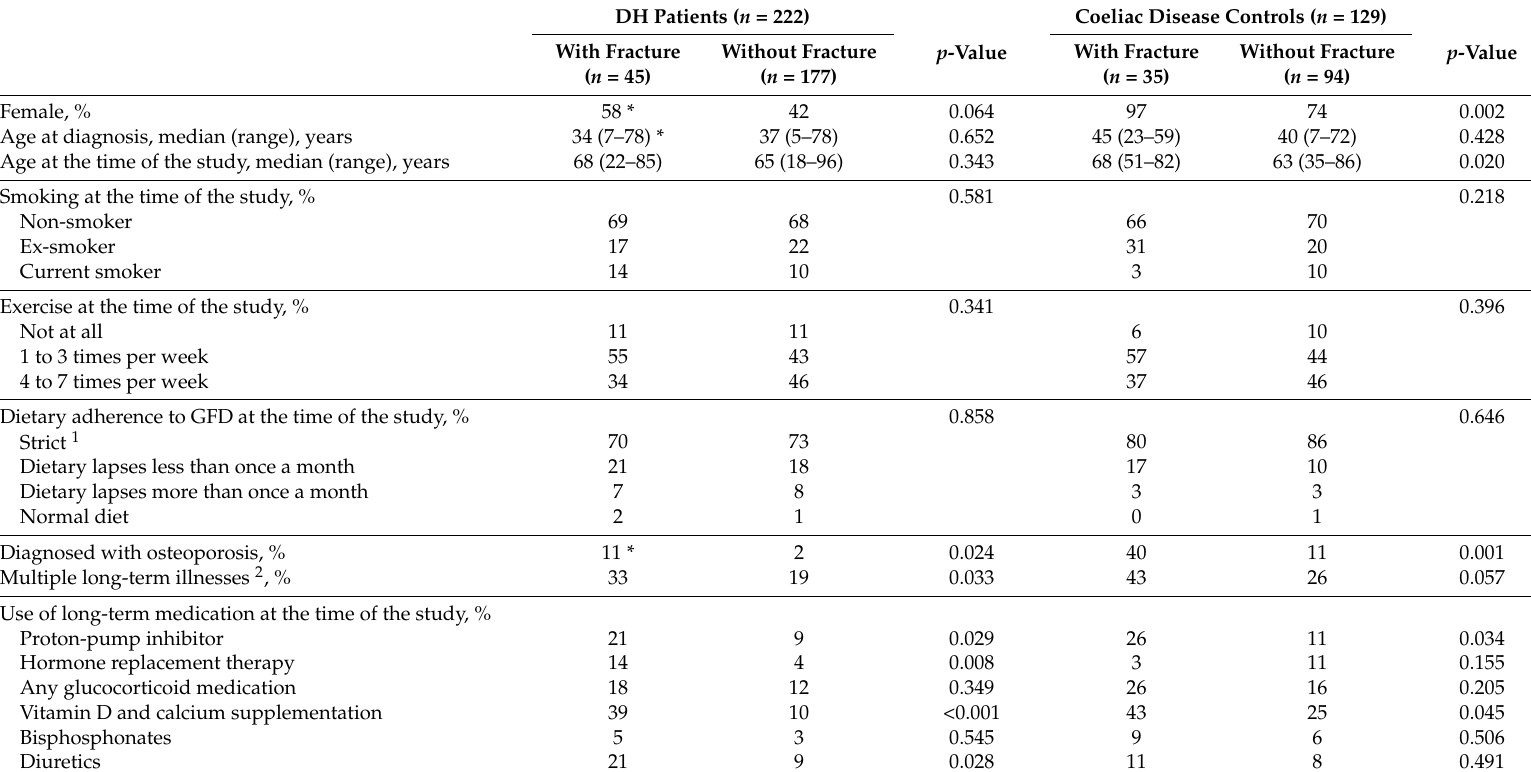
Table 2. Demographic data, strictness of gluten-free diet (GFD), and clinical data for the dermatitis herpetiformis (DH) patients and the coeliac disease controls with and without